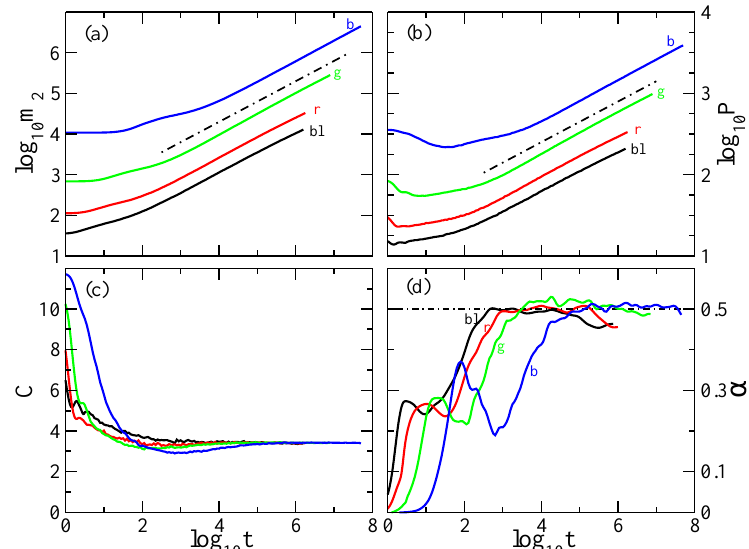
Figure 4: Density resolved strong chaos wave packet spreading. h = 0, a > d . (a) ( t ) vs. log ( t ) ∼ t 1 / 2 . (b) log m t . Dashed dotted line: m P vs. log t . log 2 2 10 10 10 10 t . (d) α vs. log t . Horizontal line: Dashed dotted line: P ( t ) ∼ t 1 / 4 . (c) C vs. log 10 10 α = 1 / 2. The parameters are: a = 0.047 and W = 1 for (b)lue line, a = 0.19 and W = 2 for (g)reen line, a = 0.4 and W = 3 for (r)ed line, a = 0.79 and W = 4 for (bl)ack line. The system size N = 2 13 , the number of disorder realizations 200 for W = 1, 500 for W = 2, 750 for W = 3, 1000 for W =